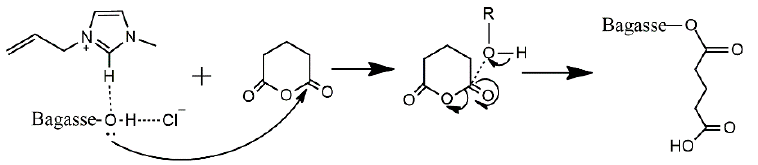
Figure 10 . The proposed esterification mechanism of bagasse modified with glutaric anhydride in AmimCl.